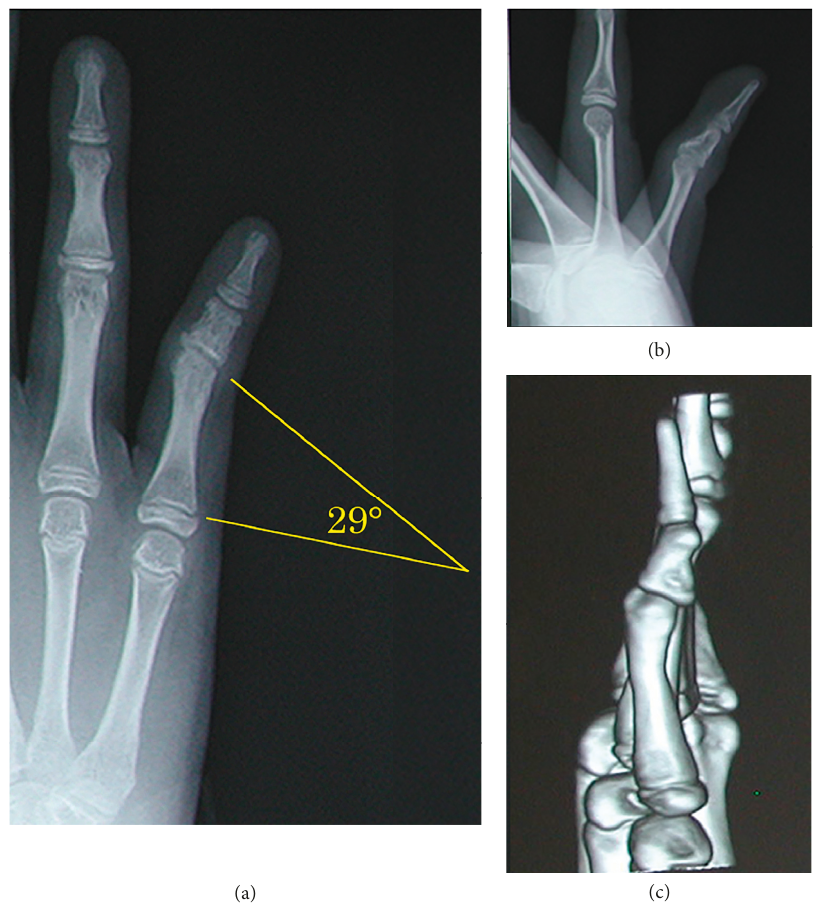
Figure 3: Preoperative imaging in Case 1. (a) Plain radiographic anteroposterior view of the right little finger. The distal articular surface of the proximal phalanx of the little finger was tilted in the ulnar direction. (b) Plain radiographic lateral view of the right little finger. (c) Three- dimensional computed tomography of the proximal phalanx of the right little finger.